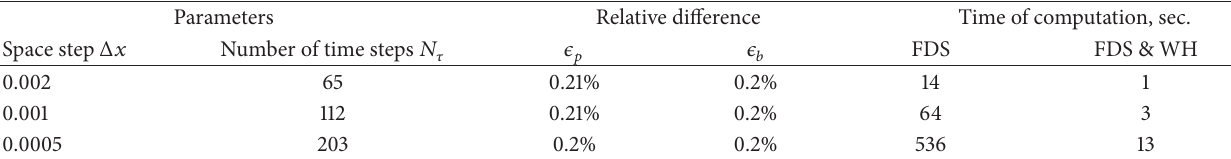
Table 3: American put, time of computation: FDS & WH versus